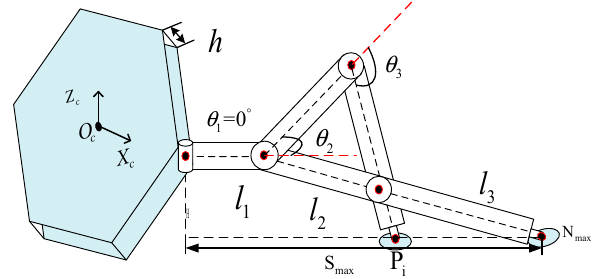
Figure 9. Limit posture of the foot tip position.